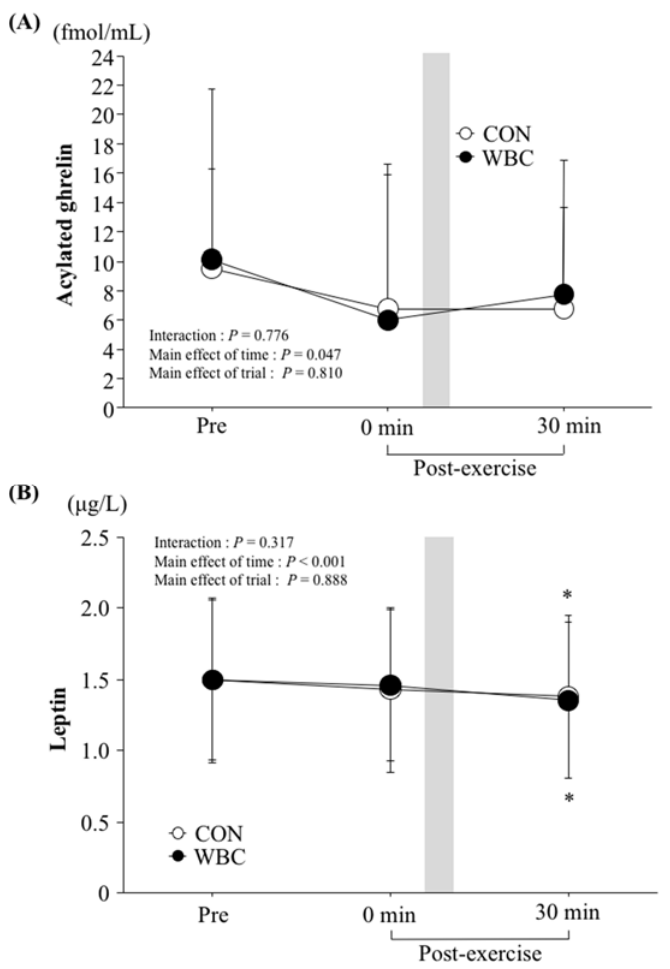
Figure 2. Plasma acylated ghrelin ( A ) and serum leptin ( B ) concentrations. Values are means ± SD ( n = 12). *: p < 0.05 vs. pre. Gray bar shows duration (3 min) of WBC treatment. WBC: whole body cryotherapy; CON: rest period.